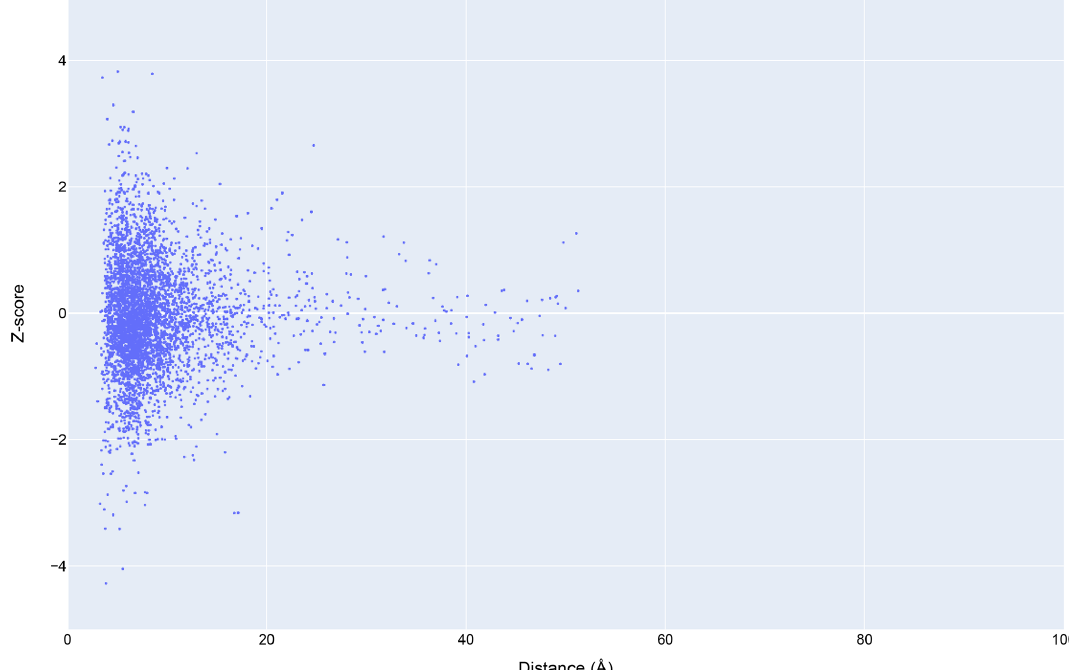
Figure 12. The distribution of amide chemical shifts for depositions citing CS-Rosetta as a function of distance from the center of the nearest ring (compare Fig.